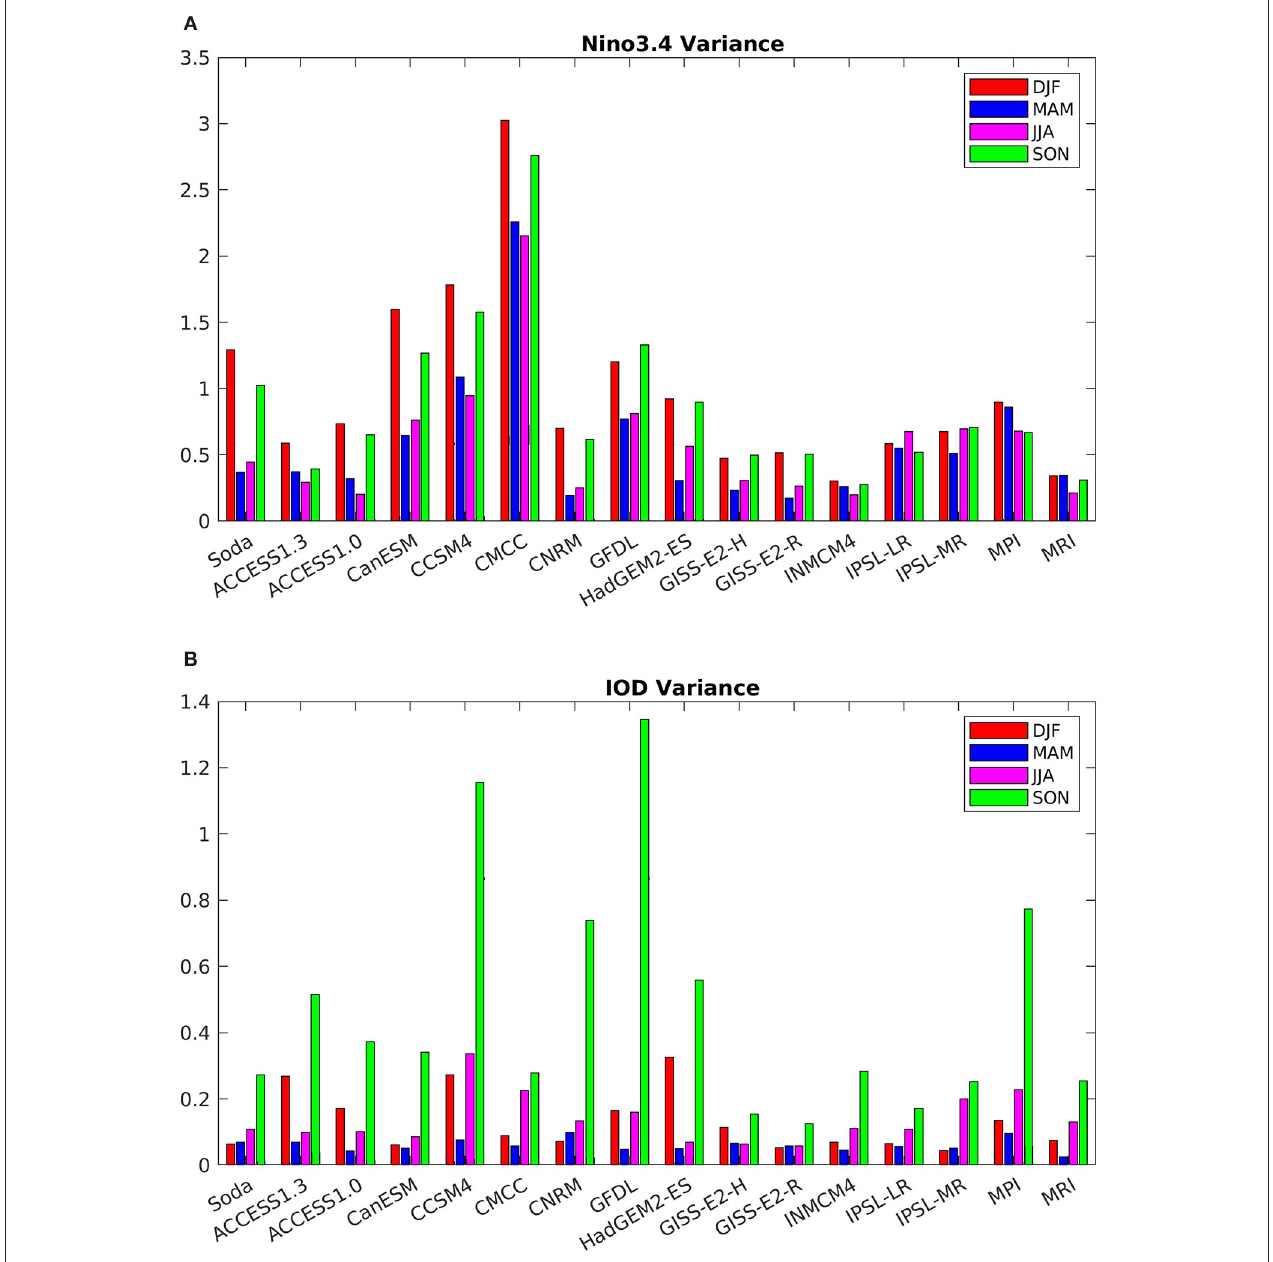
FIGURE 8 | Seasonal variance of Niño3.4 (A) and IOD (B) indices during 1967–2005 for models and during 1980–2018 for SODA